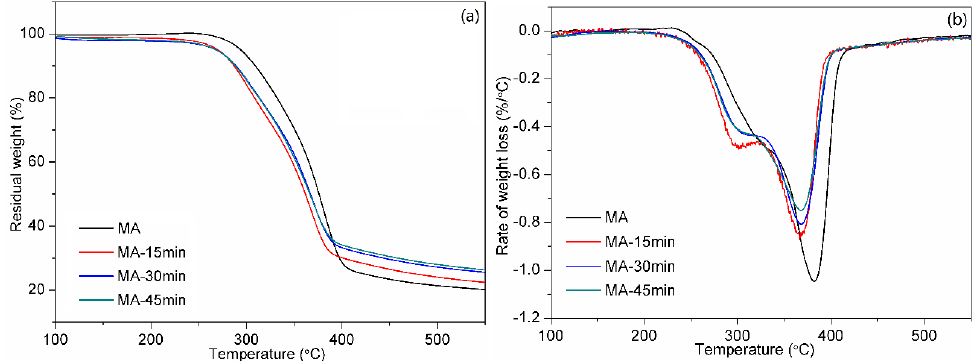
Figure 6. ( a ) TG and ( b ) DTG curves of the MA sample and the all-wood biocomposites with different hot-pressing temperatures.